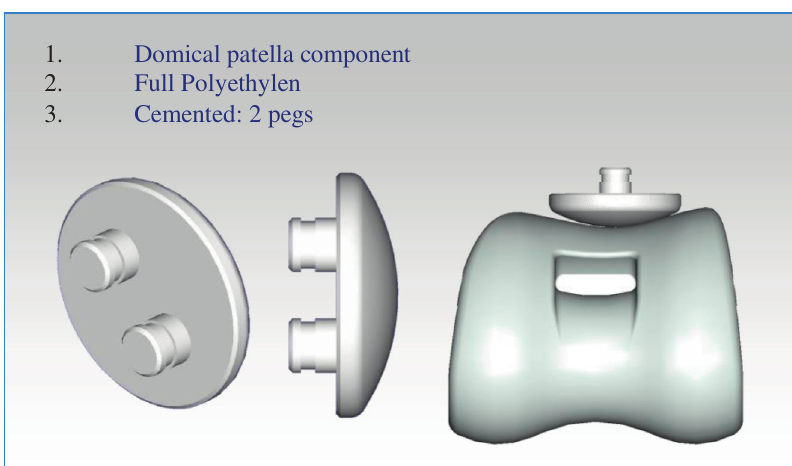
Figure 3. New Wave TKA TM patellofemoral